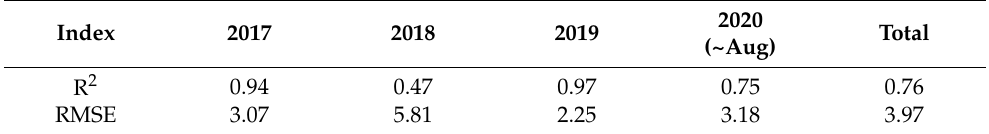
Table 6. The evaluation of the satellite-based water level and simulated water level.